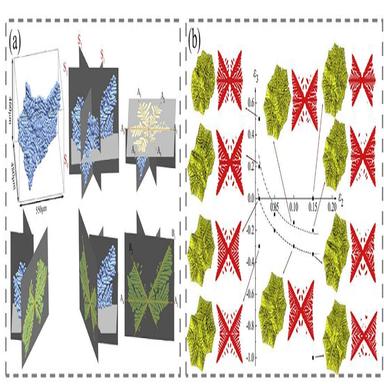
Dendritic microstructure evolution of Mg alloys under different influencing factors: (a) Further investigation of the 3D morphology of an α-Mg dendritic grain for the Mg-30 %Sn alloy ; (b) 3D phase field simulations on the dendrite orientation transition behavior of Mg alloys .